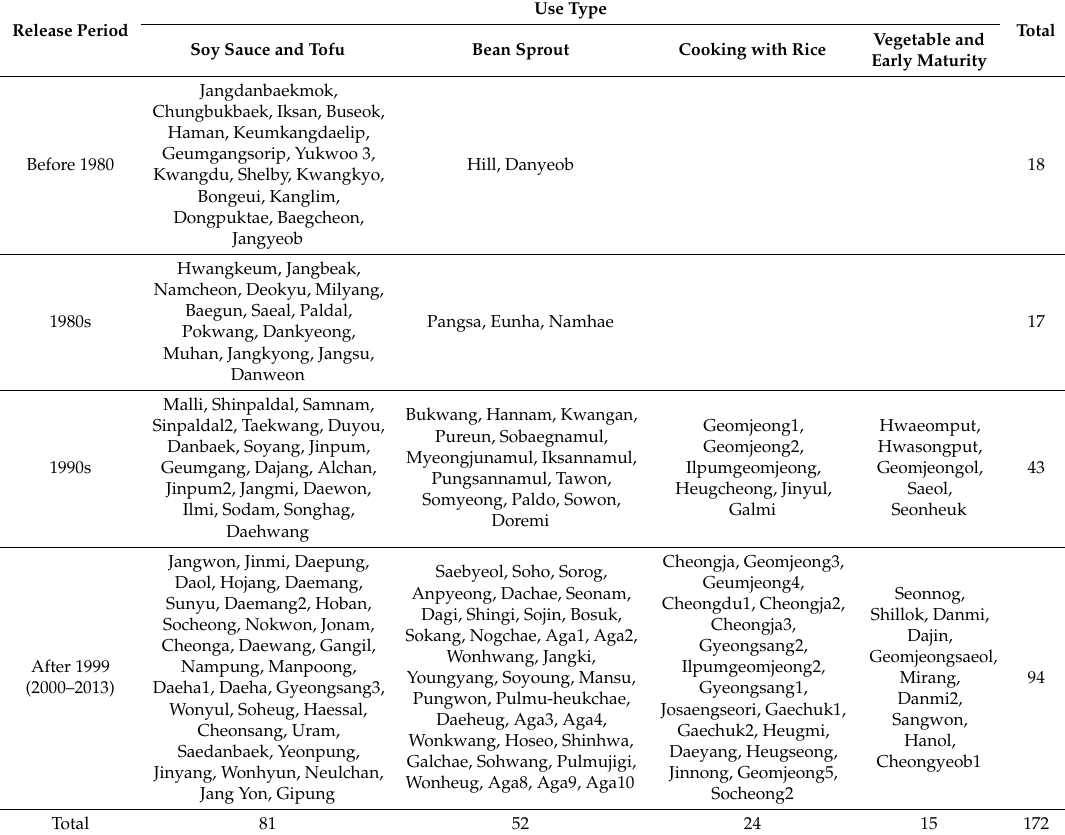
Table 1. List of 172 Korean soybean varieties, classified by release years and use type. Release